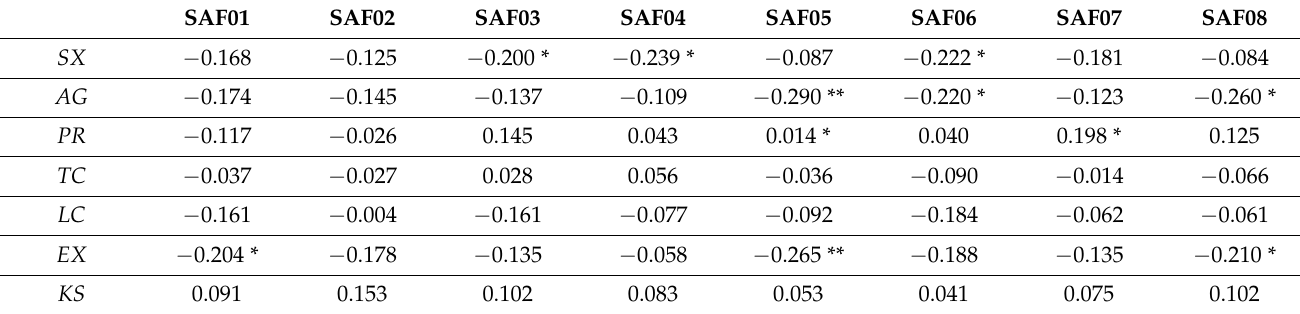
Table A6. Spearman correlation matrix: knowledge of tools associated with safety.